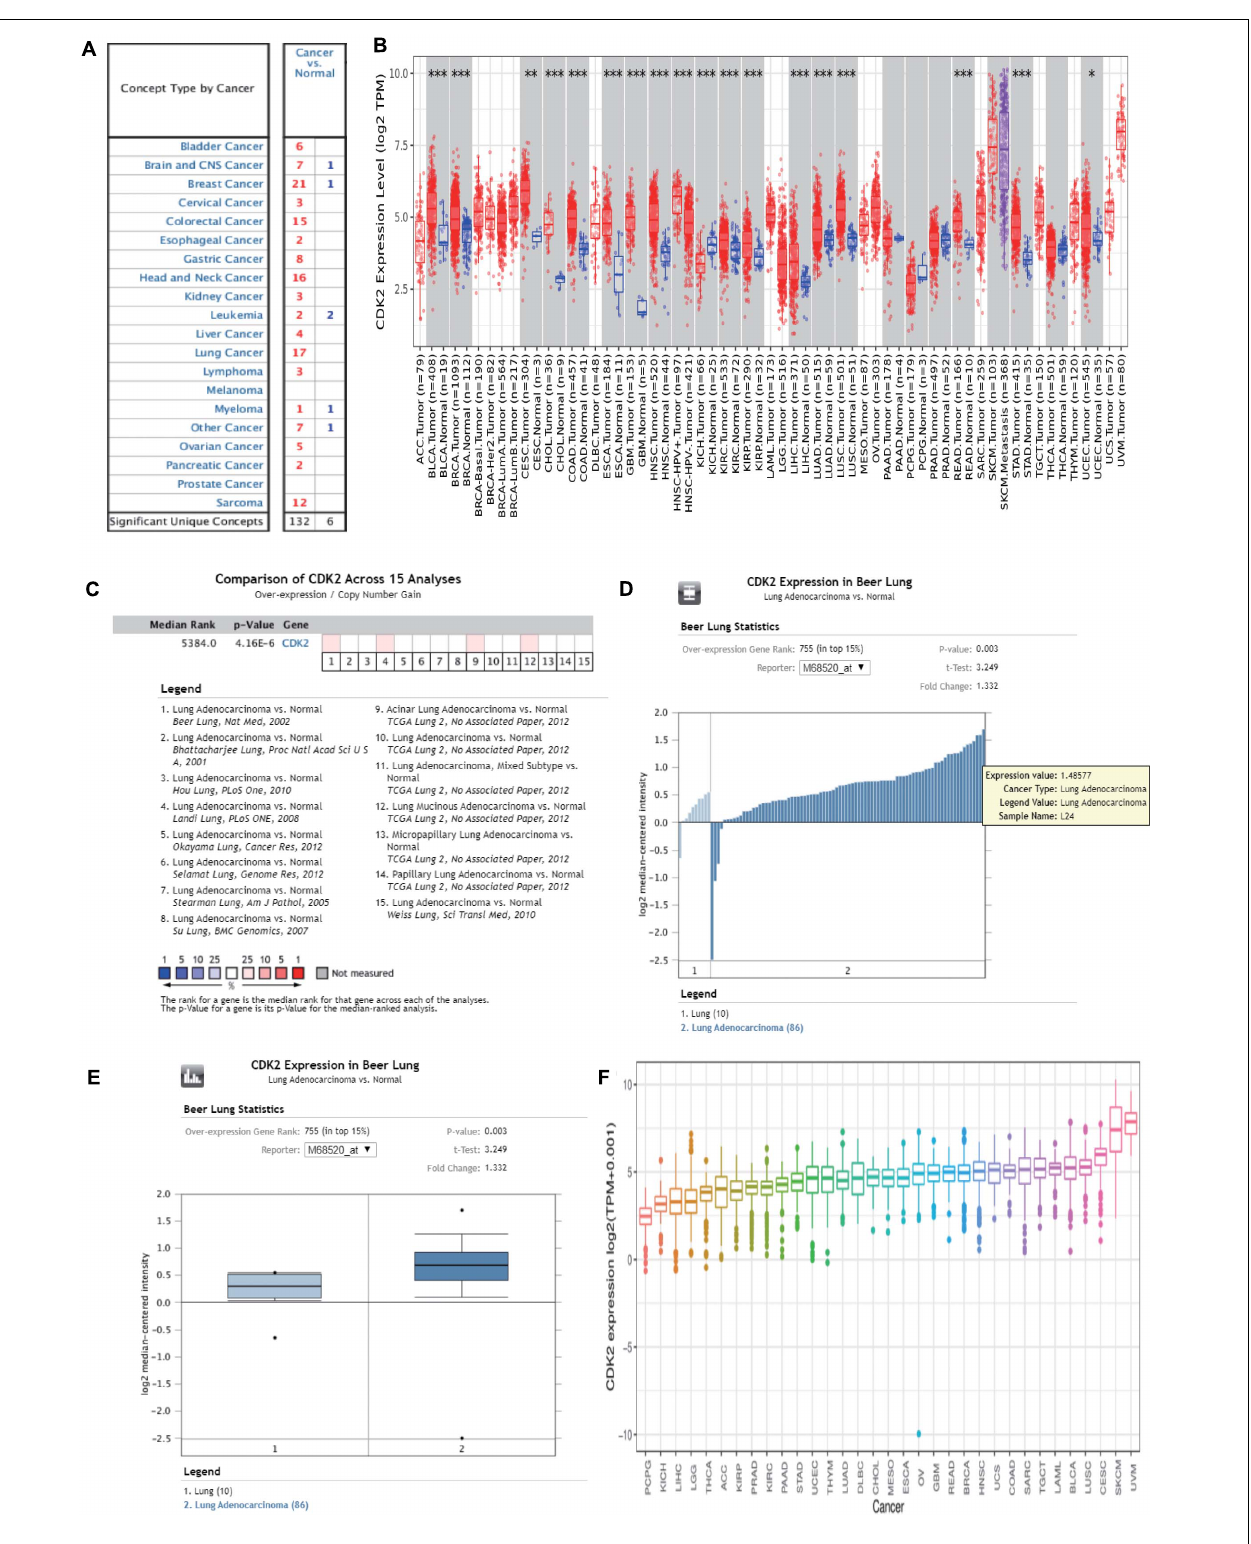
FIGURE 5 | The expression of CDK2 in pan-cancer analysis. (A) Through the Oncomine database, the expression of CDK2 was higher in 15 cancer tissues than normal tissues. (B) The expression of CDK2 in TIMER database. (C) Mata analysis of 15 published studies on LUAD showed that the expression of CDK2 was high in LUAD. (D,E) By t -test, Box plot and peak plot of CDK2 in LUAD. (F) The expression in 33 cancer, a pan-cancer analysis.